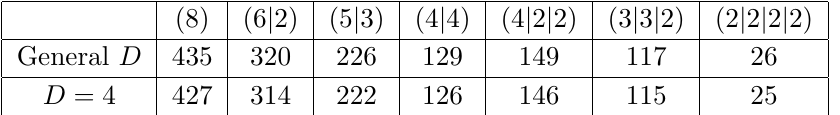
Table 7 . Number of independent 8-pt Soft Blocks at O ( p 10 ) for general spacetime dimensions D (given in [16]), and specifically for D = 4 using SSYT reductions.